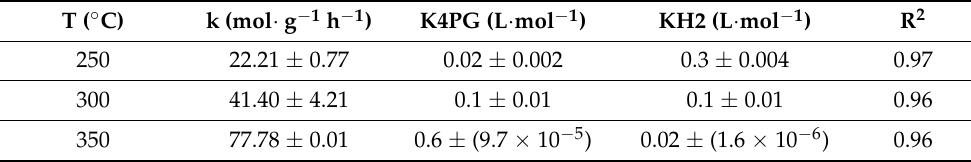
Table 2. Numerical parameters and rate constants used for the described process simulation model [3]. Reproduced from Ref. [8] with permission from the Royal Society of